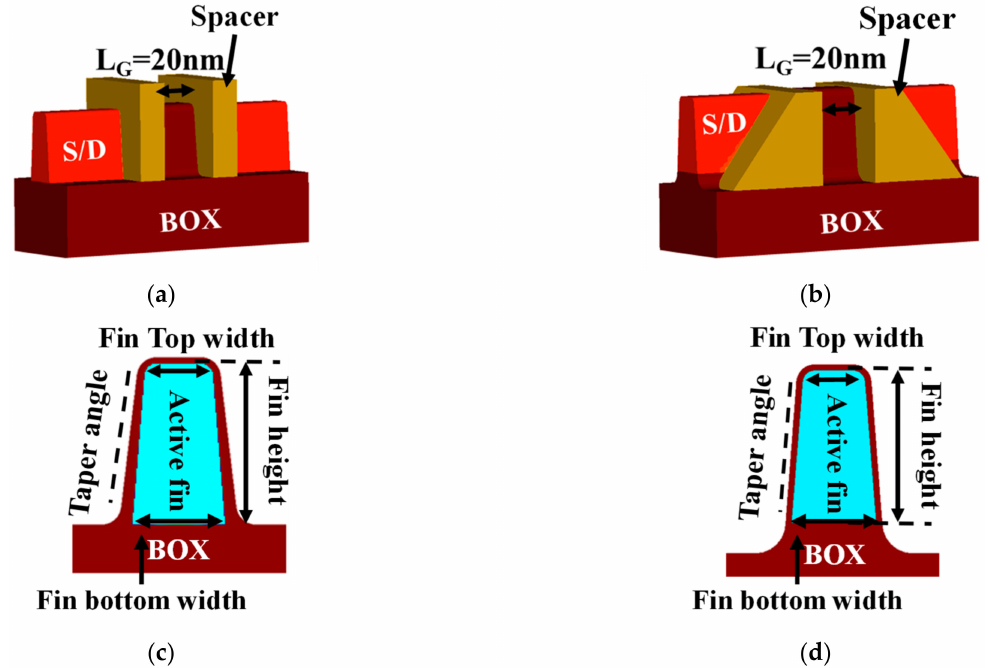
Figure 2. Simulated SOI FinFET structures for TID hardening evaluation. ( a , b ) 3D schematics of a conventional design and the proposed rad-hard design, respectively; ( c , d ) fin cross-sections in a conventional device and the rad-hard device,